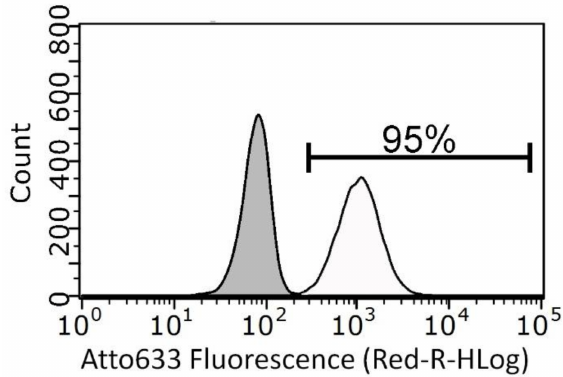
Figure 10. Representative flow cytometry curves of stained Atto 633 ZnO-mw-NH 2 NCs uptake in KB cells. Grey area represents the untreated cells signal while the white one was obtained by cells incubated with 10 µ g/mL ZnO-mw-NH 2 stained with Atto633 for 24 h. Quantification of positively stained events, characterized by a shift in fluorescence intensity compared to untreated cells, was calculated setting a positive threshold beyond the grey area. Each condition is done in